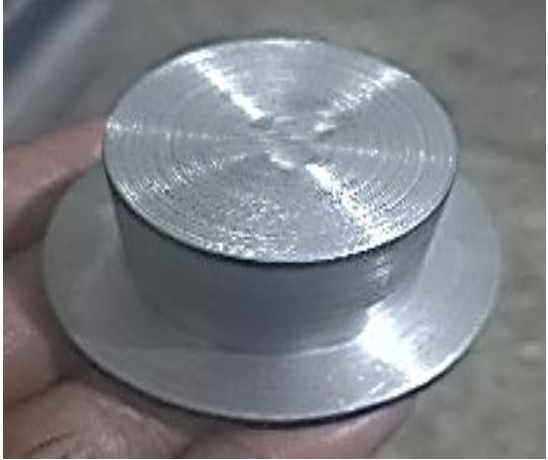
Figure 5. Base of desired part.